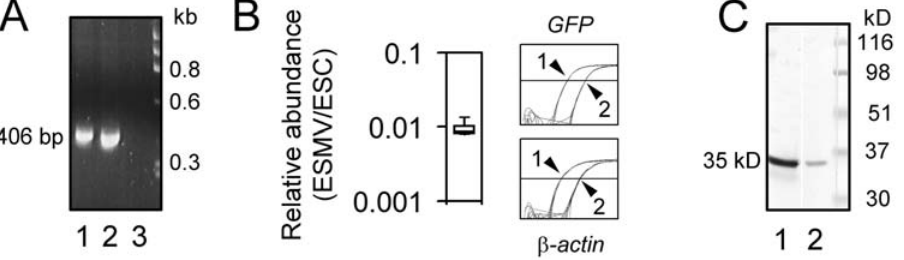
Figure 3. ESMVs contain GFP mRNA and protein expressed from a GFP transgene in ESCs. (A) 300 ng of ESMV RNA from an ESC line expressing GFP were used for RT, and 35 cycles of PCR amplification were performed with the GFP primers shown in Table 1. A 2% agarose gel was loaded with the RT-PCR products from ESMVs (lane 1), ESCs (lane 2), and a ‘‘no RT’’ control of ESMVs (lane 3). A 406bp band corresponding to the GFP amplicon is observed in both the ESMV and ESC lanes. (B) (Left) Box plot of relative abundance of GFP in ESMVs compared with ESCs (n=8). (Right) Comparison of amplification curves for GFP (top) and b -actin (bottom) in ESCs (1) and ESMVs (2). Note that while quantitative RT-PCR was performed in the linear range of amplification, (panel B), the end-point PCR products shown in panel (A) are only qualitative and well outside of the linear range. (C) Immunoblot of an 8% urea-SDS polyacrylamide/Tris-glycine buffered gel loaded with 20 m g total protein/lane, using polyclonal anti-GFP antibody (1:1000) and horse anti-rabbit secondary antibody (1:5000). The secondary antibody was conjugated to alkaline phosphatase and visualized with BCIP/NBT. A single , 35kD immunoreactive band corresponding to GFP in ESCs (lane 1) and ESMVs (lane 2) was detected.